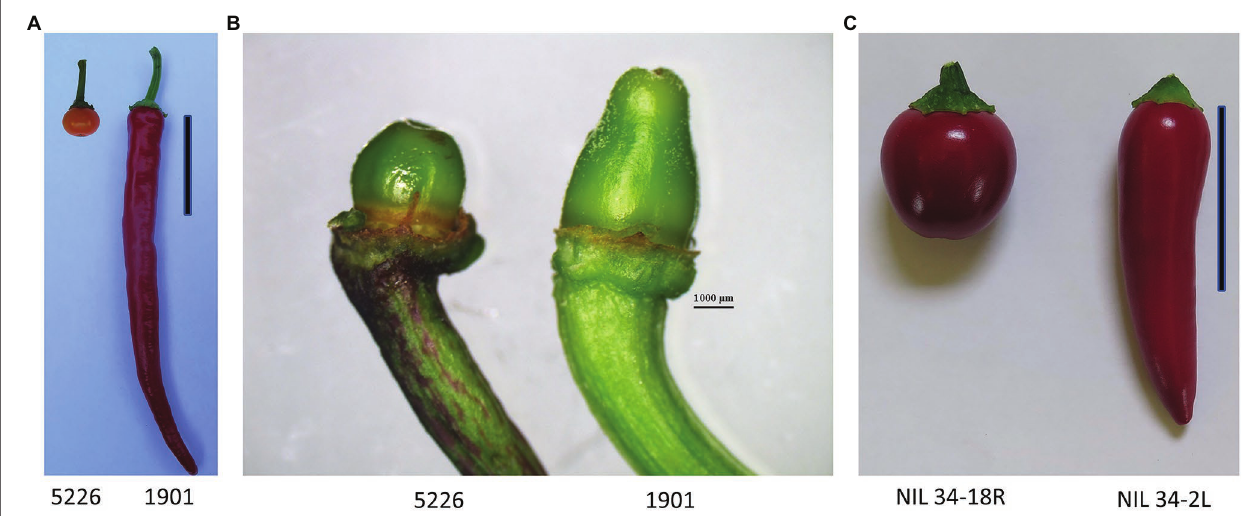
FIGURE 1 | Fruit and ovaries of parents and near-isogenic lines (NILs) used in this study. (A) Ripe fruit of the mapping parents 5226 and 1901. (B) Ovaries at anthesis of the mapping parents 5226 and 1901. Ovary photos were taken by a Leica MZFLIII binocular. (C) Ripe fruit of the fs10 -NILs 34-18R and 34-2 L. Scale bar = 5 cm.